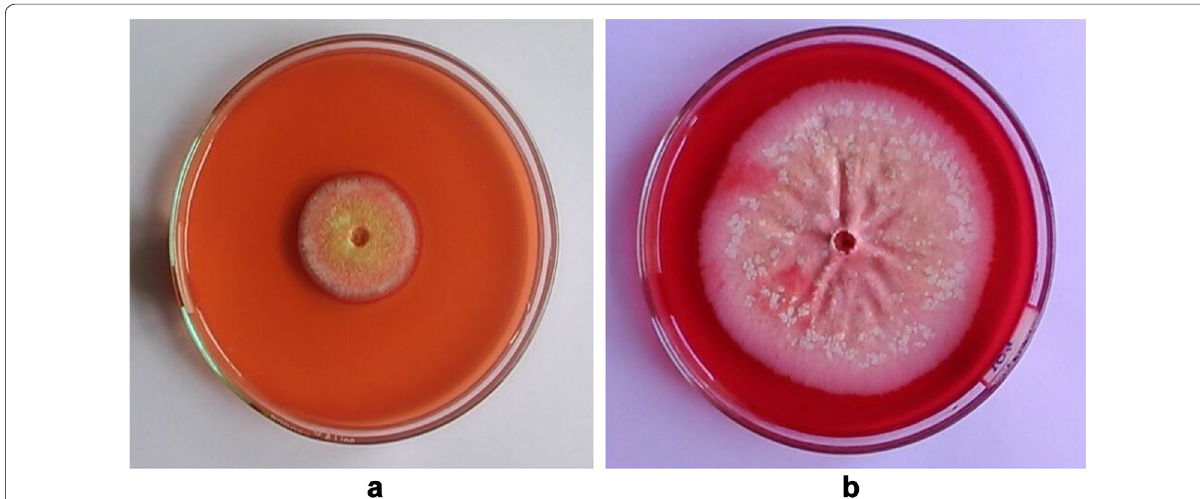
Fig. 1 Detection of cellulase activity from the isolated fungal strain on agar plates. Plates showing the zone of hydrolysis by Aspergillus fumigatus JCM 10253 with Congo red staining on the 7th day. a Plate without CMC; b plate with CMC as a substrate